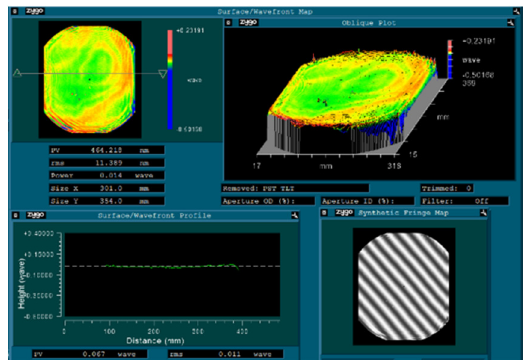
Through several iteration of MRF figuring and robot polishing, the surface shape error can be reduced to satisfied the requirement. The surface shape error for primary mirror is 11.4nm RMS (see figure 5), and for tertiary mirror is 12.1nm RMS (not show here).